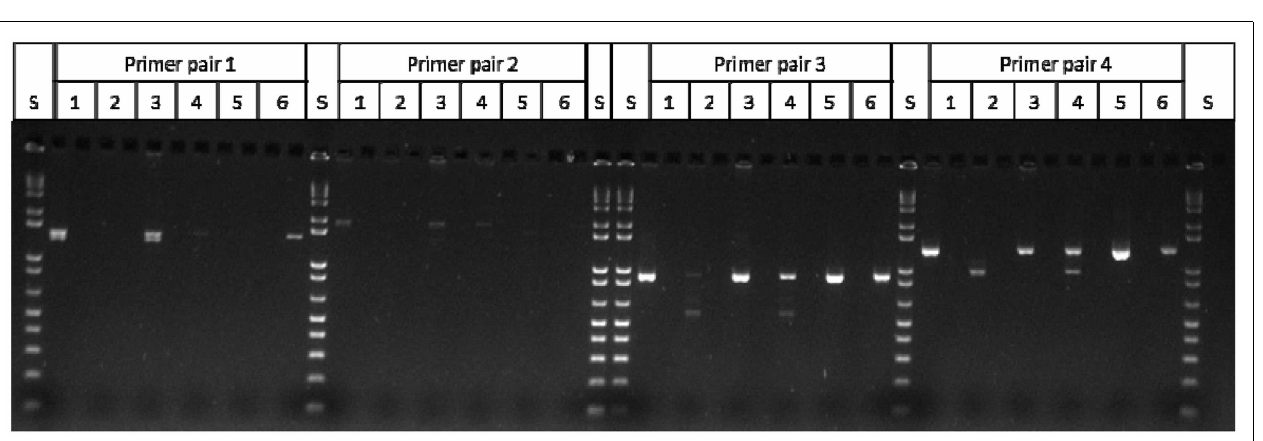
FIGUREA1 | Mu killer individuals undergoing Mu killer silencing accumulate aberrant Mu killer transcript types. S = 1kb plus DNA ladder; Lanes 1–4 = Mu killer gDNA “ + ” individuals; Lanes 1 and 3 accumulate expected transcript types; Lanes 2 and 4 accumulate aberrant transcript types; Lane 5 = mudrA control DNA; Lane 6 = Mu killer control DNA; Primer Pair 1: amy4-flank + mudrA-899r (expected